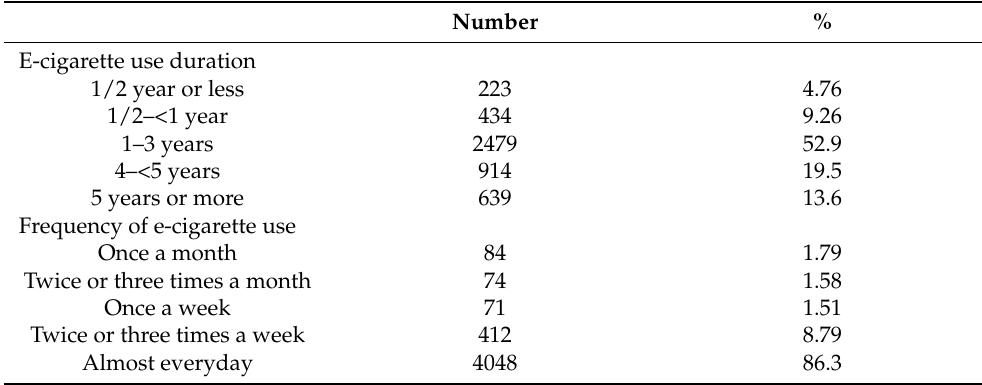
Table 2. Detailed e-cigarette use behaviors ( n =